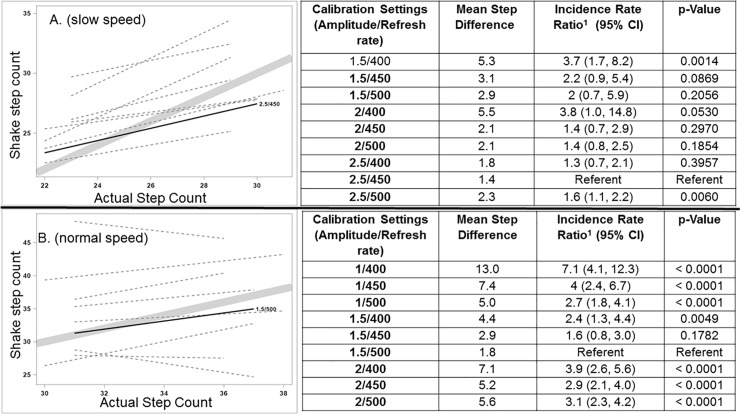
Calibration of Shake Algorithm across normal (2a) and slow (2b) speeds and models (name type) to determine the best fit to the observed step count line. For slow speed (2a.) 1.5/500 (sensitivity/refresh time) achieved the minimal step count difference from the observed step count (1.8 steps). For normal speed (2b) 2.5/450 (sensitivity/refresh time) achieved the minimal step count difference from the observed step count (1.4 steps).